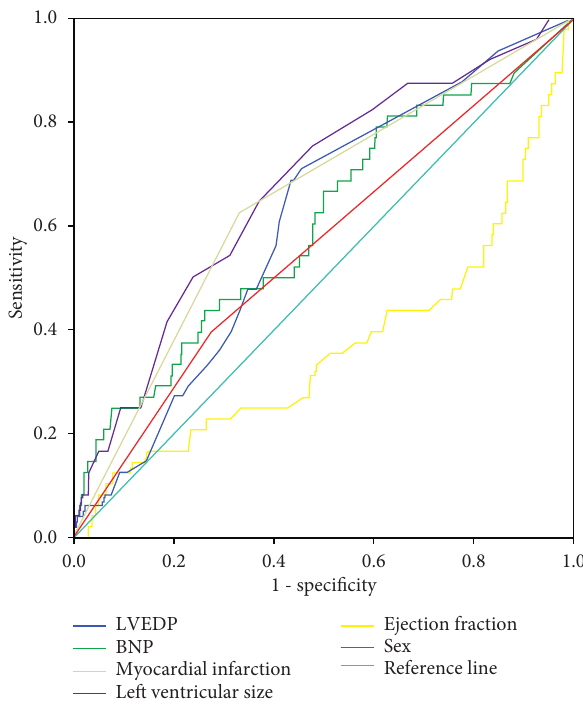
Figure 1: The area under the curve for the predictive performance of different indexes for contrast-induced nephropathy incidence in the cohort. BNP, B-type natriuretic peptide; LVEDP, left ven- tricular end-diastolic